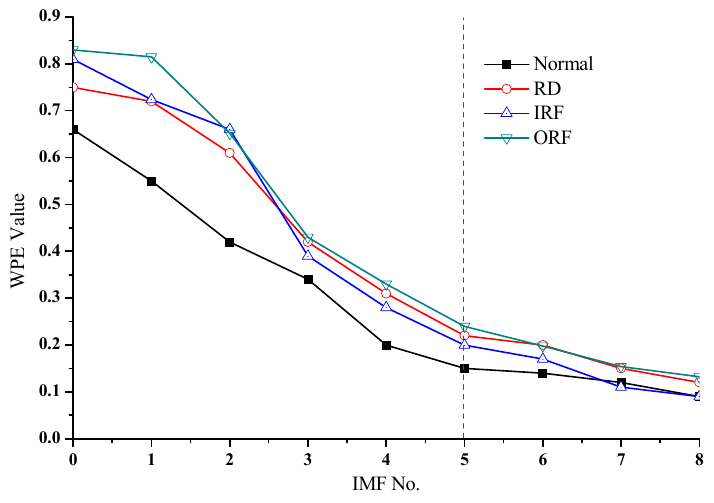
Figure 12. WPE values of IMFs under different fault modes.